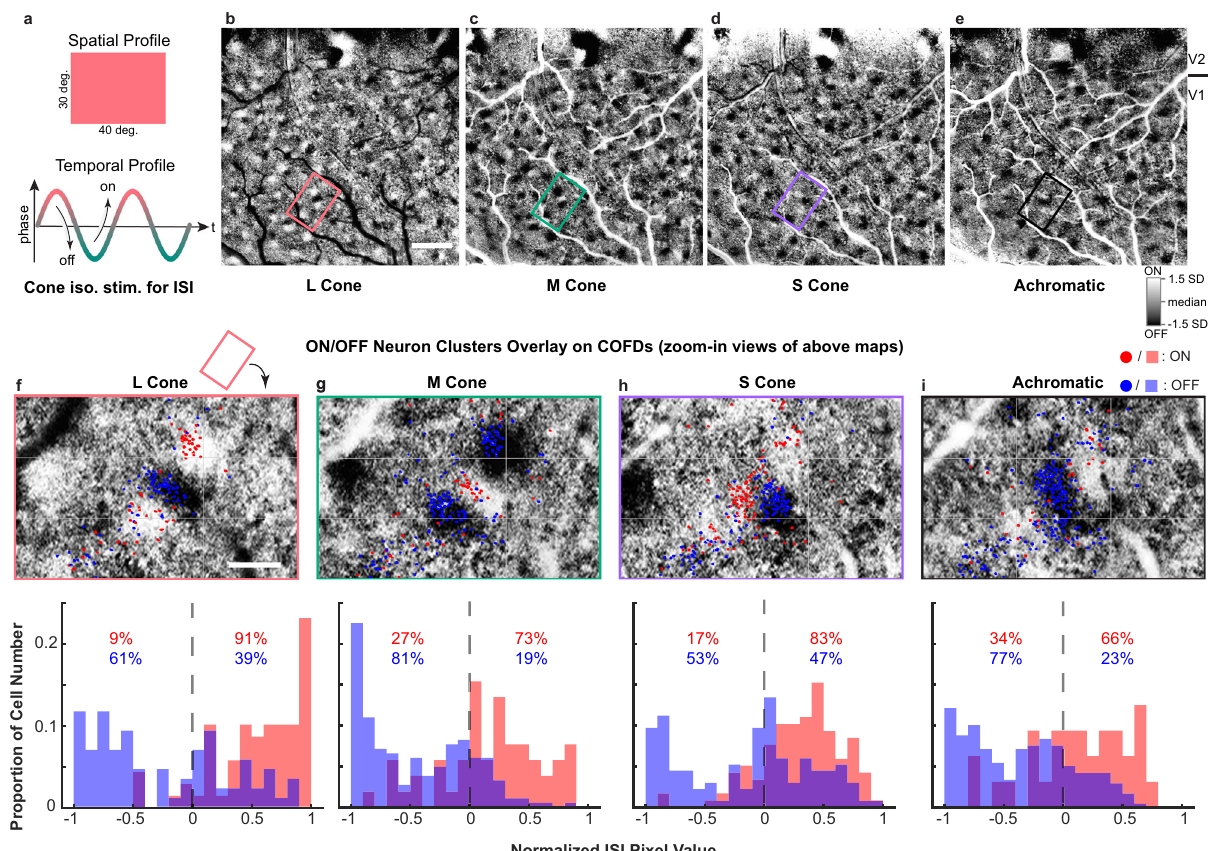
Fig. 3 | COFDs obtained from ISI are aligned with ON and OFF neuron clusters from 2PCI. a Continuous-periodic full- fi eld cone-isolating and achromatic stimuli (top) with corresponding sinusoidal temporal modulation (bottom, L-cone- isolating stimulus is shown). b – e ISI phase maps reveal ON and OFF functional domains resulting from L-, M-, S-cone-isolating and achromatic stimuli, respec- tively. Scale bar: 1mm. (SD: standard deviation of pixel distributions). f – i ON/OFF neuron clusters aligned with COFD. Panels at top: 2PCI responses of neurons (colored dots, the same as Fig. 2i) to L-, M-, and S-cone-isolating and achromatic stimuli superimposed on corresponding aligned zoom-in ISI phase maps from regions outlined in b – e . Individual neurons imaged with 2PCI depicted based on